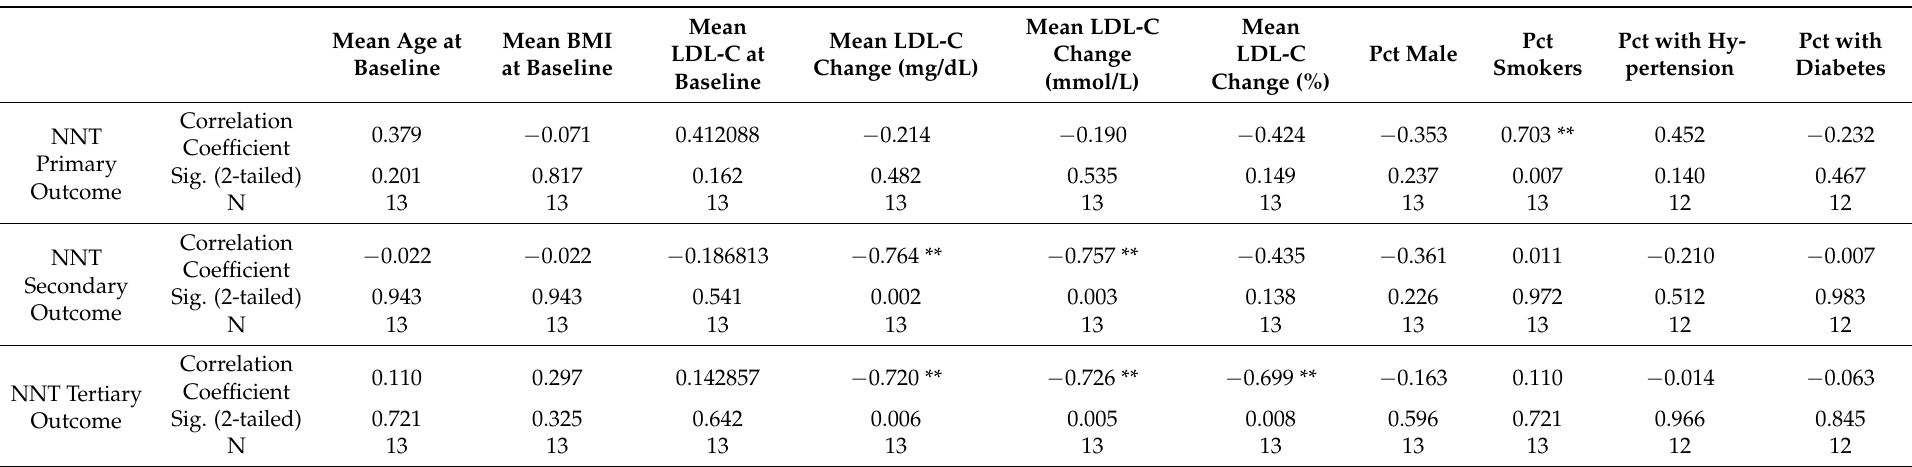
Table 8. Meta-regression analysis showing the relationships between NNT/year and confounding